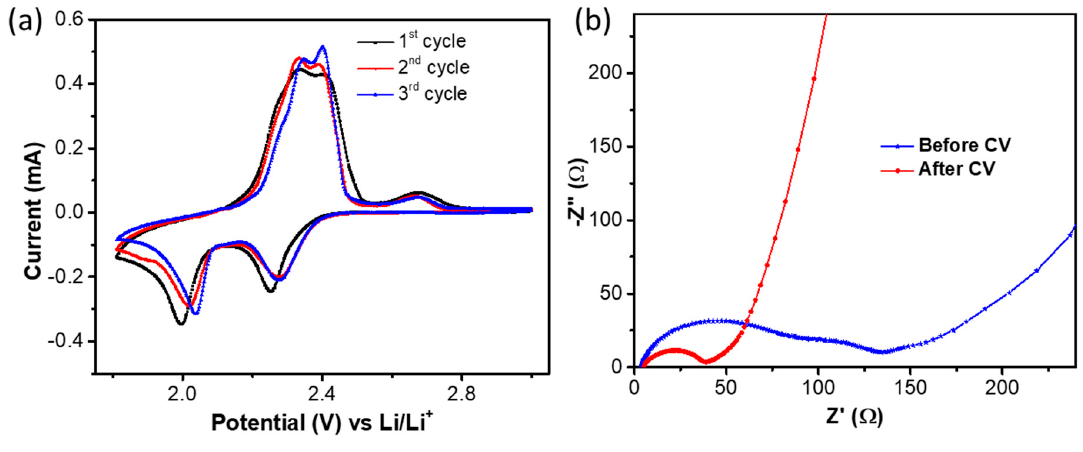
Figure 4. ( a ) Cyclic voltammograms and ( b ) AC impedance spectra of the CSC/S